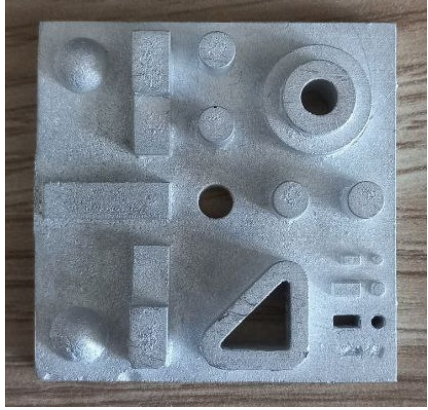
Figure 7. Cast part.